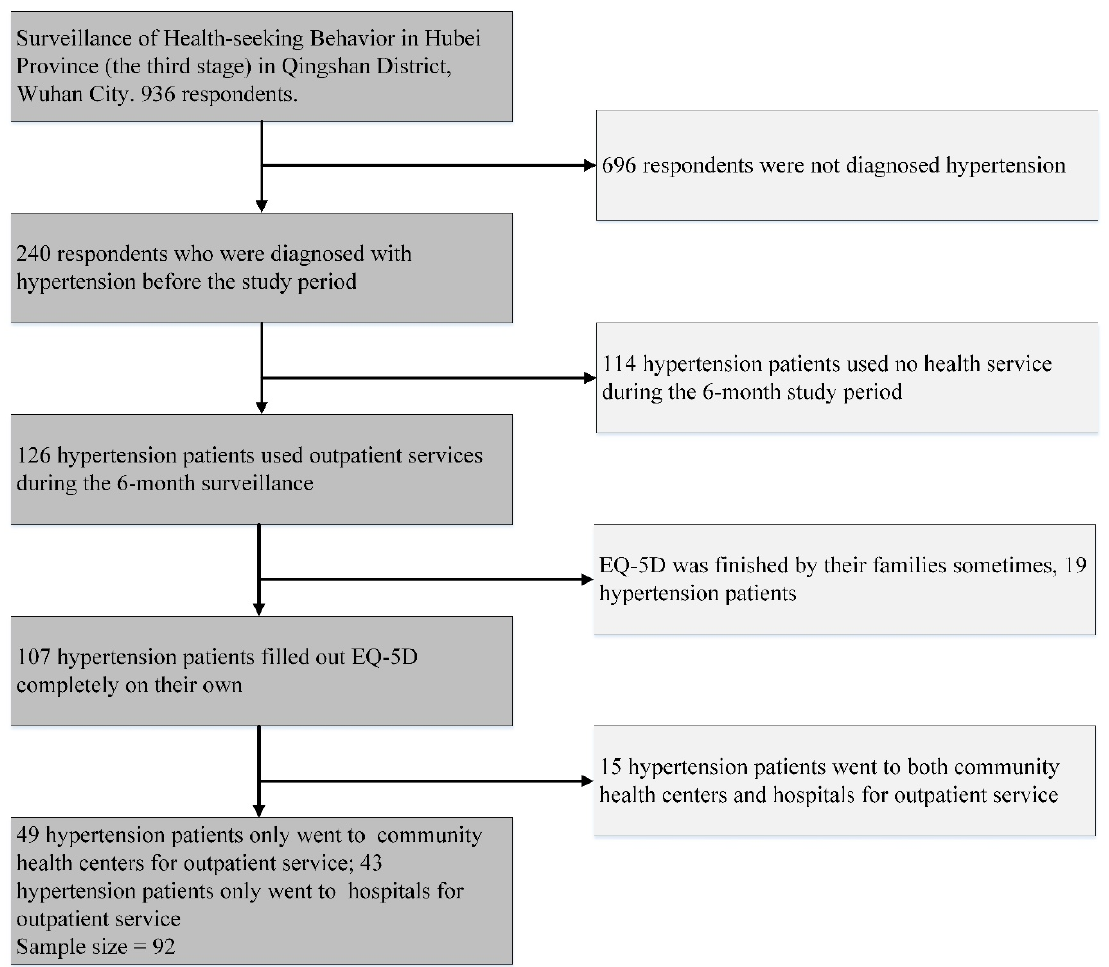
Figure 1. Procedure of sample selection.